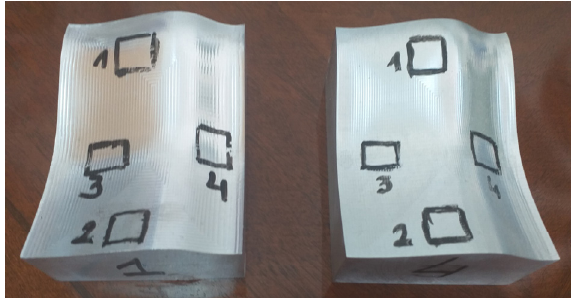
Figure 10. Machined surface with marked zones for EXP and EXP4